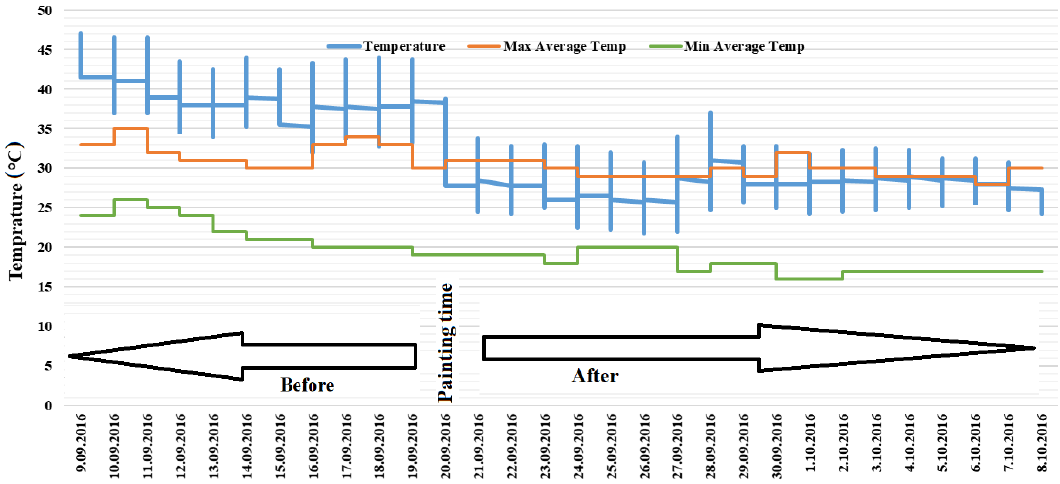
Figure 8. Measurement values of daily average and maximum/minimum temperatures for TR2.